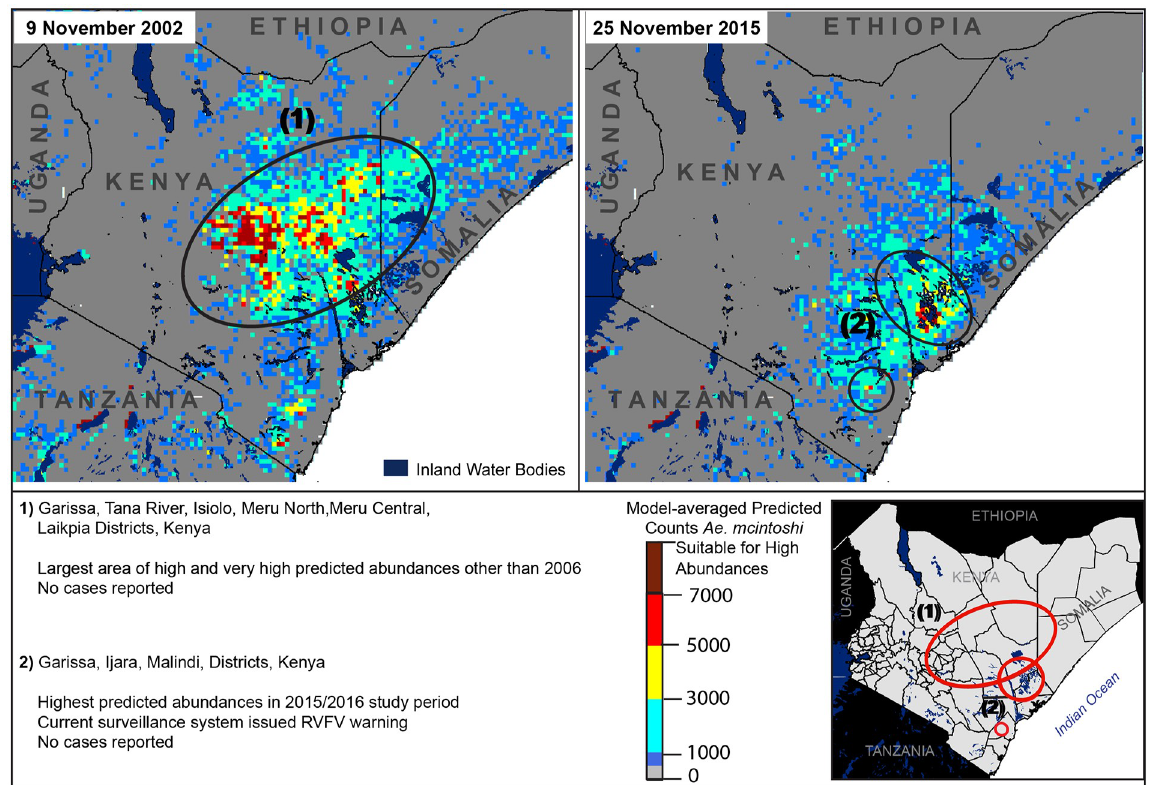
Fig 6. Predicted elevated abundances during interepizootic year 2002 (left panel), and lower predicted abundances during the 2015/2016 time period, when current RVFV surveillance systems issued warnings, but no virus was reported (right panel). District boundaries fall inside circles in the lower right panel, with corresponding information provided below the panel